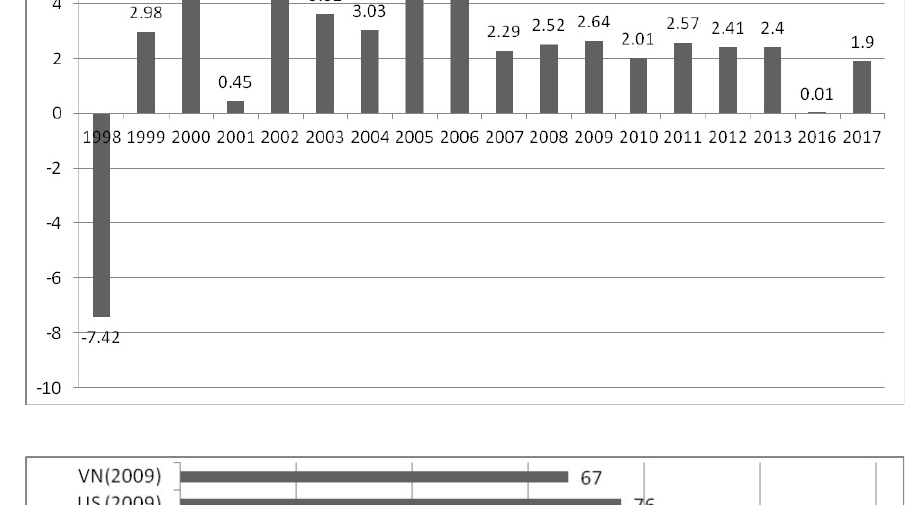
Figure 3. Share of